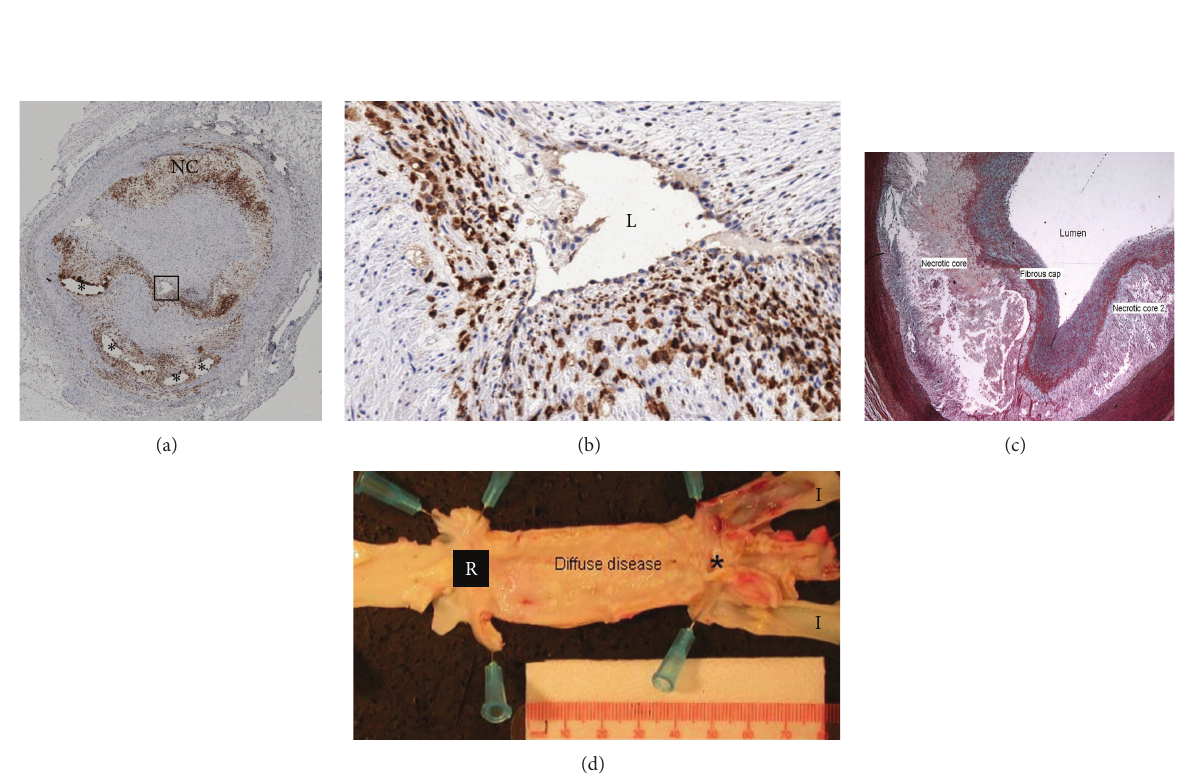
Figure 1: Examples of atherosclerotic lesions from DM/HC pigs. (a) Low power magnification of a coronary artery with a severe atherosclerotic lesion, obtained 6 months after DM/HC induction. Artery stained with Cathepsin S (brown cells) to denote the presence of inflammatory cells showing protease activity. Lumen is within the outlined box, ∗ —calcification and NC-necrotic core. (b) High power view of outlined area in (a) with L denoting the arterial lumen. Cathepsin positive areas near the lumen indicate a thinned fibrous cap with increased inflammation. (c) Movat’s staining of a high-risk coronary fibroatheroma showing two large necrotic cores covered by a fibrous cap. (d) Longitudinal view of the abdominal aorta demonstrating severe, diffuse atherosclerosis between the renal arteries (R) and the distal bifurcation ( ∗ ) into the iliac arteries (I). The ostia of the iliac arteries are generally severely diseased in this